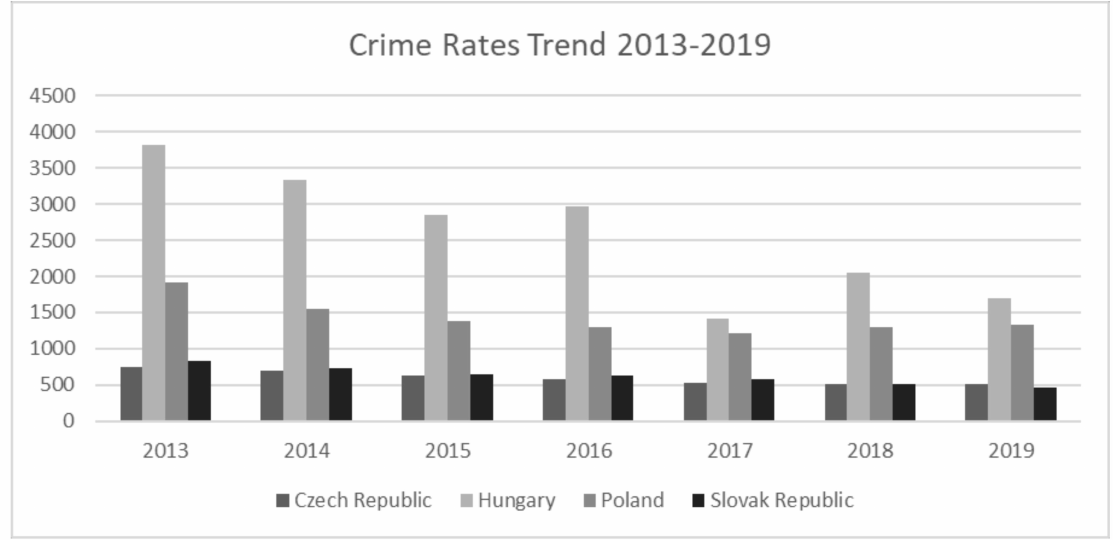
Figure 4. Crime rates for the Czech Republic, Hungary, Poland, and Slovakia, 2013–2019. As we can see for the number of criminal offences across the years, a decline from 742 per 100,000 inhabitants in 2013 to 520 in 2019 was observed in case of the Czech Republic, with the exception of an anomaly observed in 2018. Similarly, for Poland,